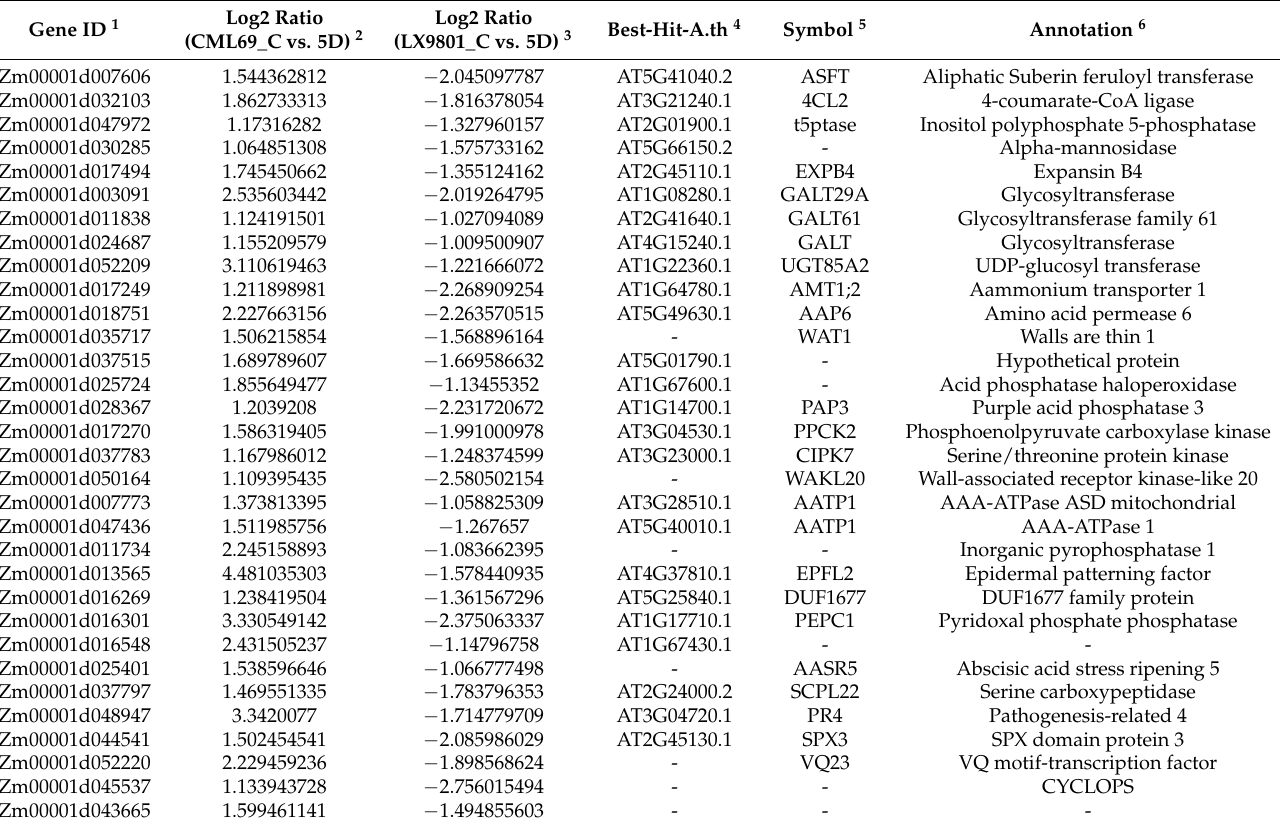
Table 5. Thirty-three drought-responsive DEGs upregulated in CML69 but downregulated in LX9801 at 5D drought stress. Gene ID